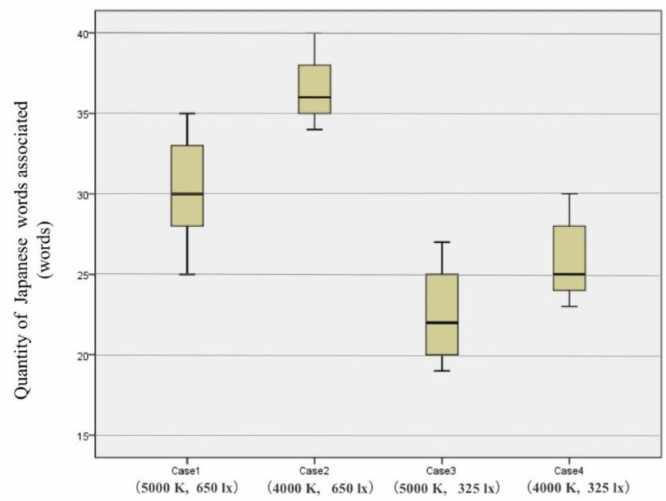
Figure 4. Comparison of the quantity of associated Japanese words in different illumination